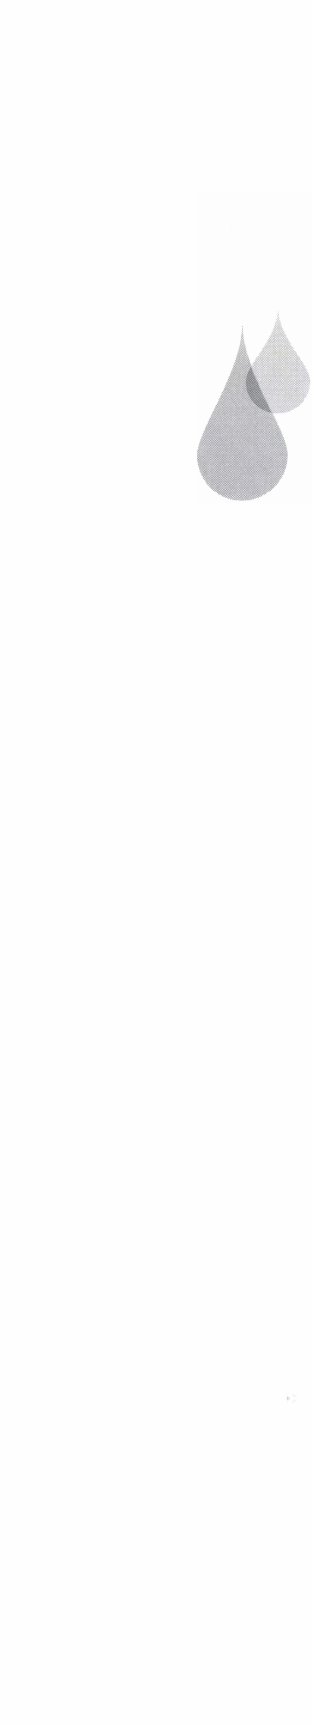
Fig. 5: Effect of partial cross­ linking and the pH value on viscosity